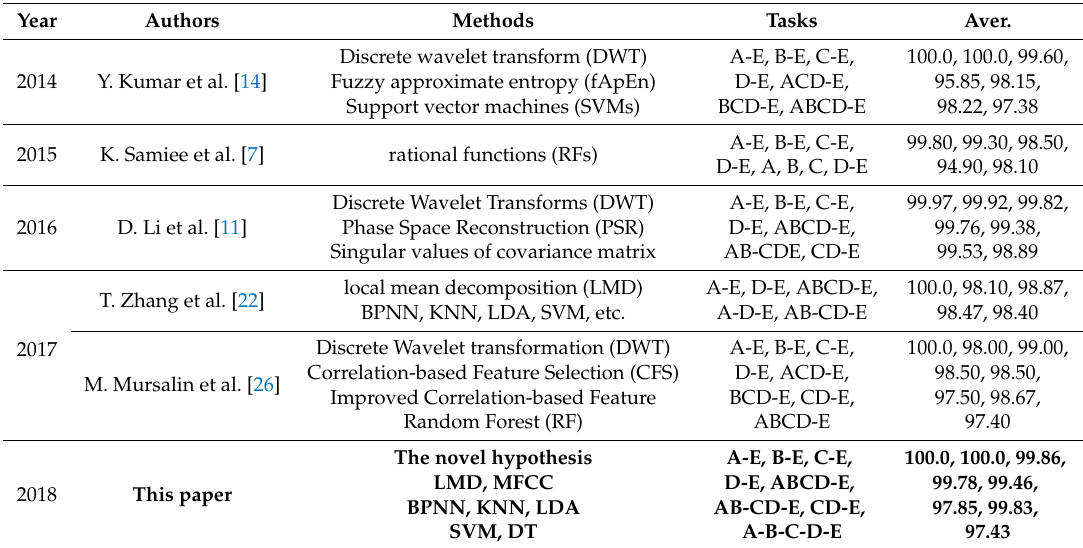
Table 9. The comparison between this method and other methods using the same